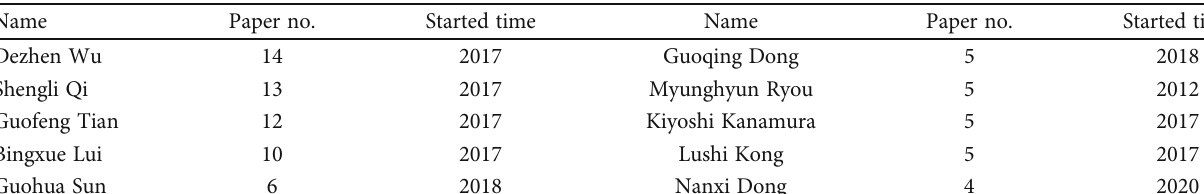
Table 2: Top ten authors with the most published papers.